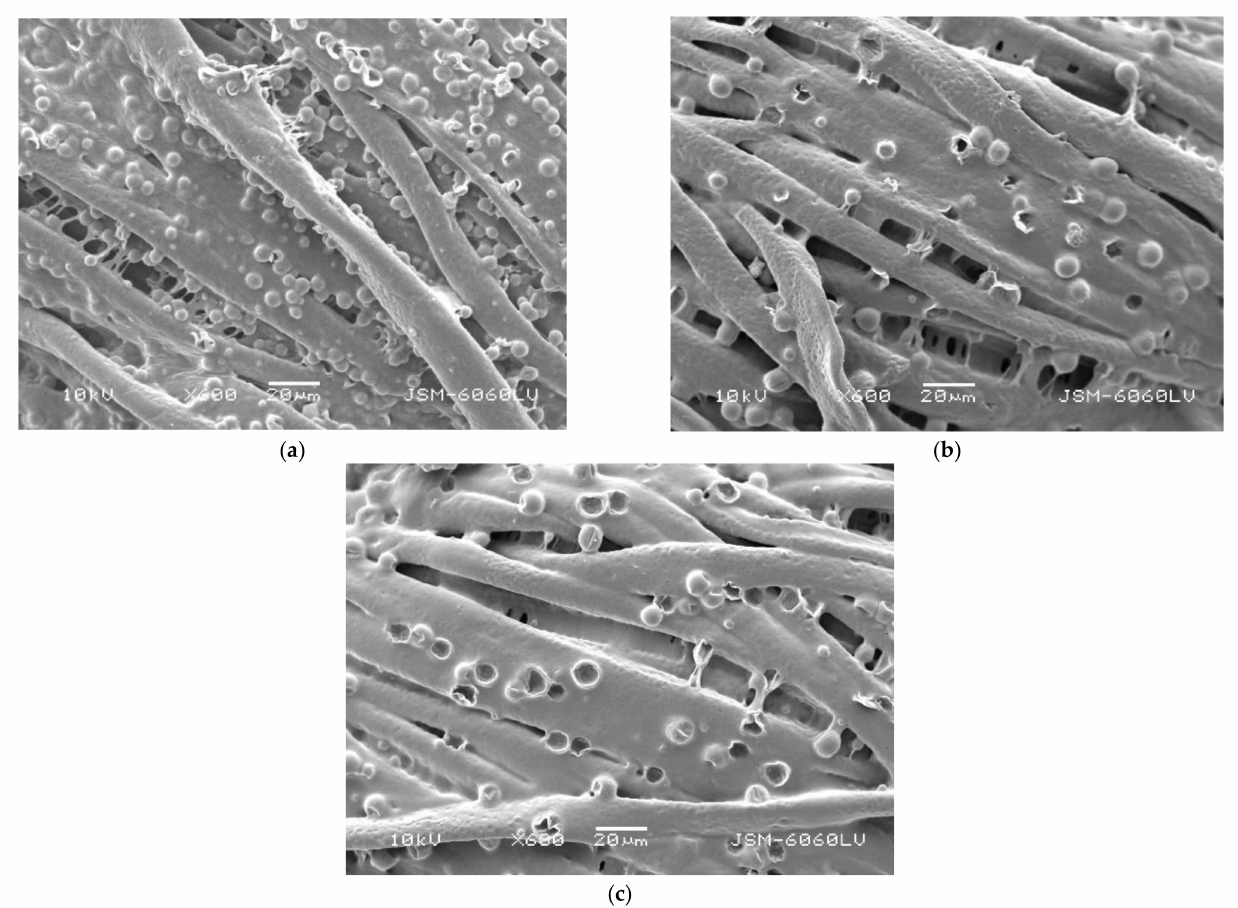
Figure 3. SEM micrographs of printed ( a ) unwashed, ( b ) 5 times washed and ( c ) 10 times washed sample.